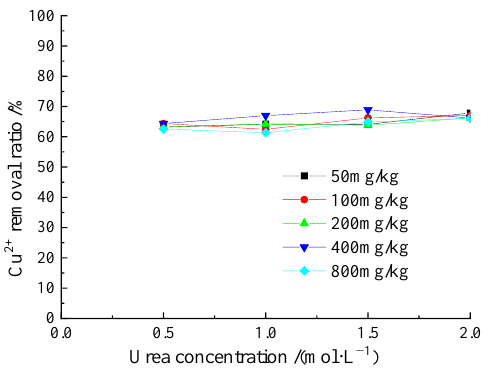
Figure 7. Removal ratio of Cu 2+ without Ca 2+.